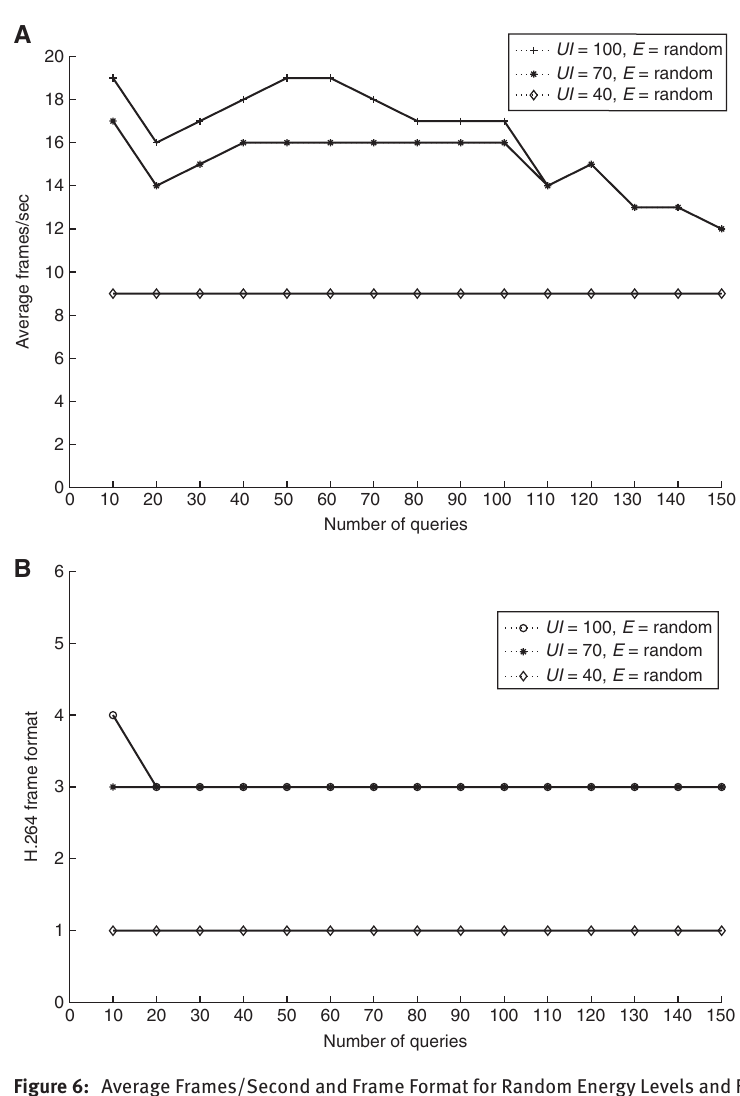
Figure 6: Average Frames/Second and Frame Format for Random Energy Levels and Fixed User